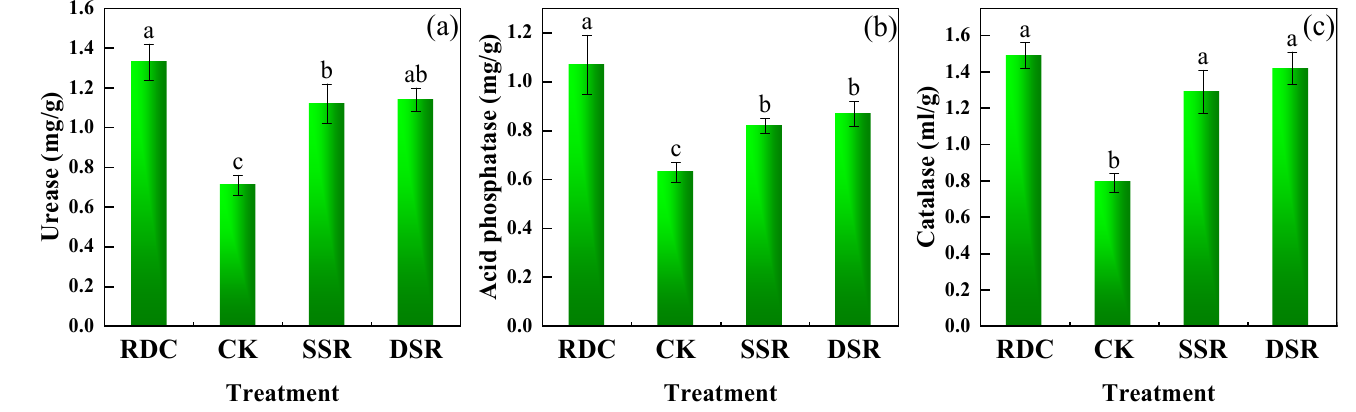
Figure 6. Effects of different planting patterns on soil enzyme activity. (a) Urease, (b) Acid phospha- tase, (c) Catalase. Small letters show the significant difference.